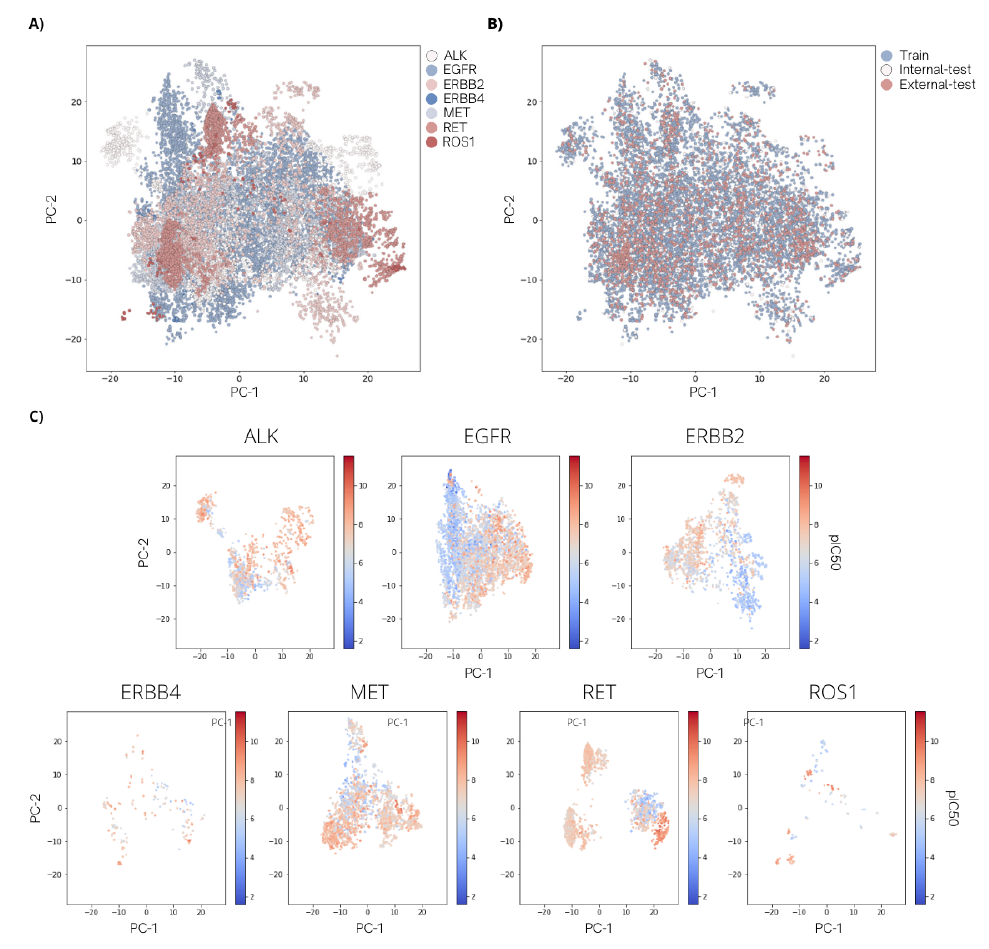
Figure 2. Chemical distributions of the dataset after curation specified by ( A ) target activity and ( B ) divided datasets used in this study. ( C ) Two-dimensional PCA plots for seven tyrosine kinase datasets after AC analysis with pIC 50 values presenting in color scales; the greater the values, the more potent the compounds to the particular